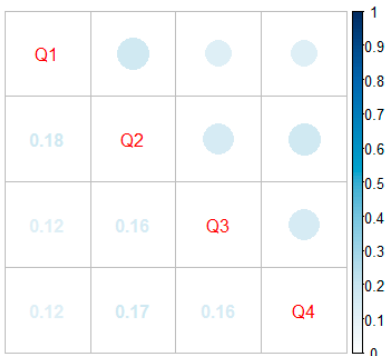
Figure 3. Correlation plot between various transition probabilities. Q1, Q2, Q3 and Q4 denote (